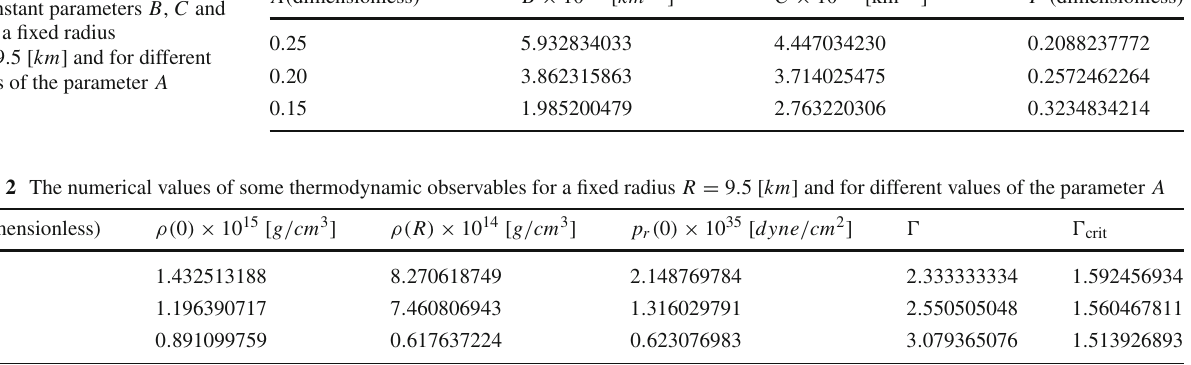
Table 1 The numerical values of constant parameters B , C and F for a fixed radius R = 9 . 5 [ km ] and for different values of the parameter A